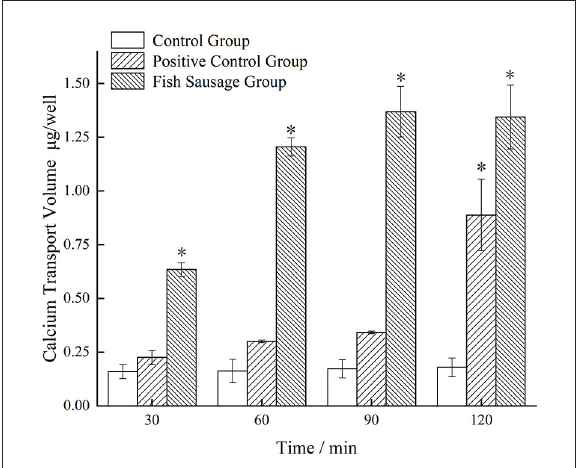
FIGURE4 The calcium transport through Caco-2 cell monolayer model of simulated digestive fluid of bass sausage in vitro . Comparison among the three groups: * P <